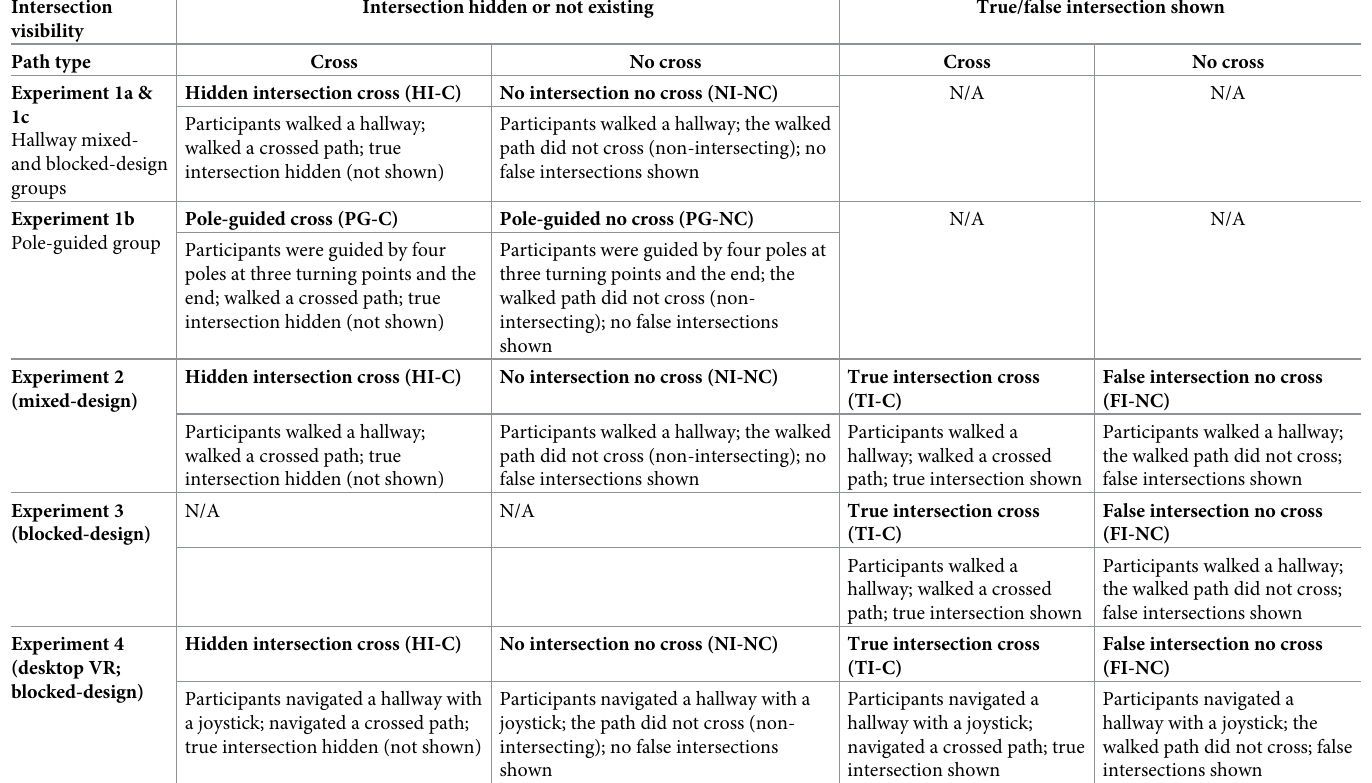
Table 1. Experimental design and conditions.